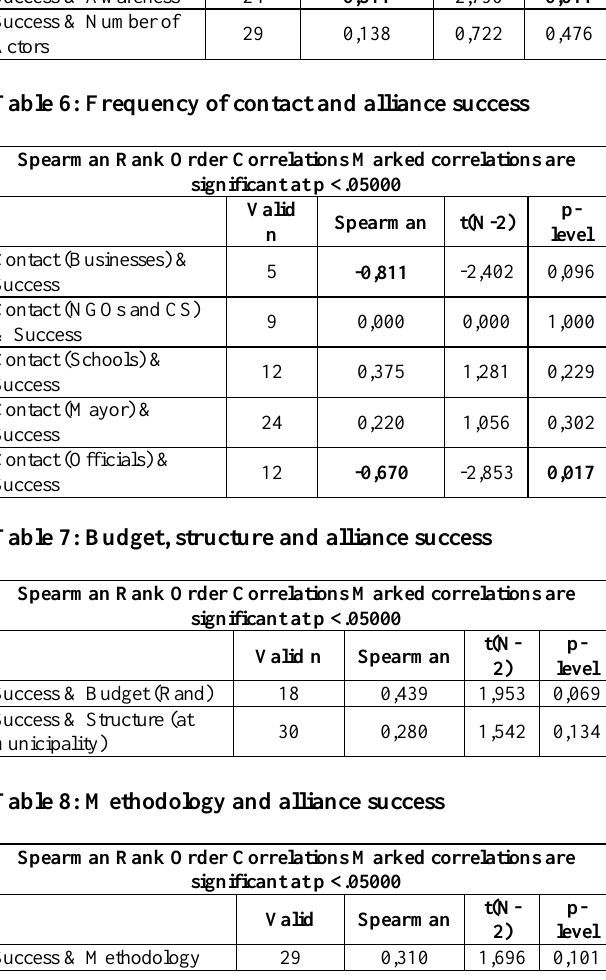
Table 9: Management, commitment, structure and alliance